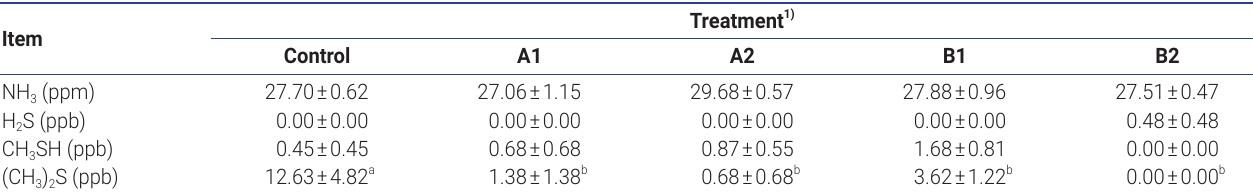
Table 6. Effects of dietary metallo-protease and Bacillus velezensis CE 100 on noxious gas emission in broiler chickens